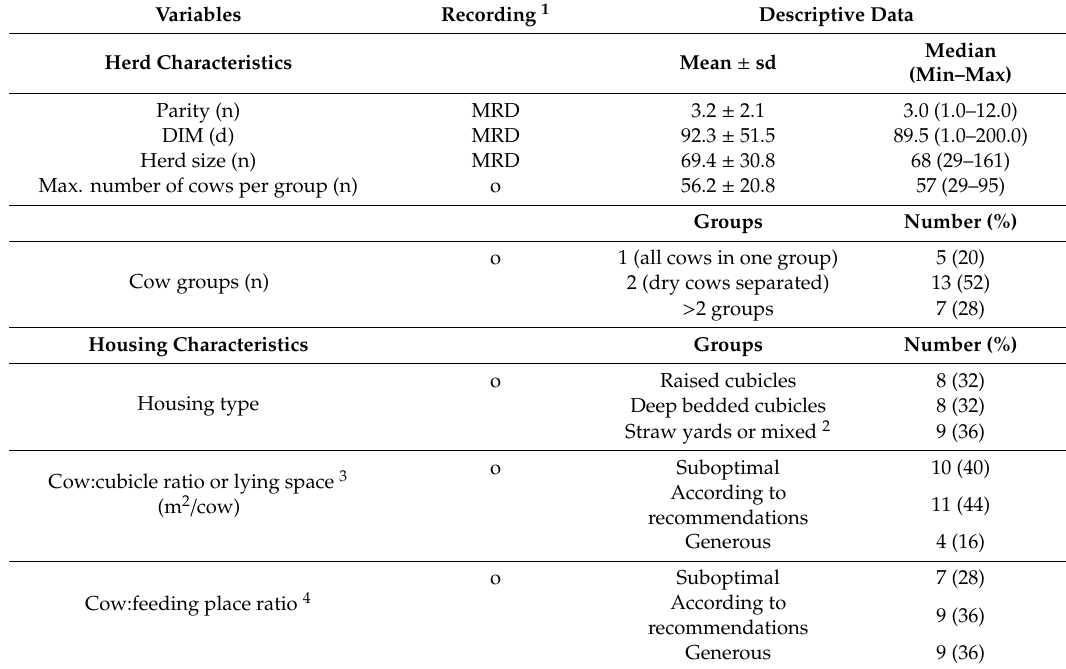
Table 1. Descriptive data on herd, housing, and management characteristics at farm level ( n = 25), and on cows’ parity and days in milk (DIM) at animal level ( n =